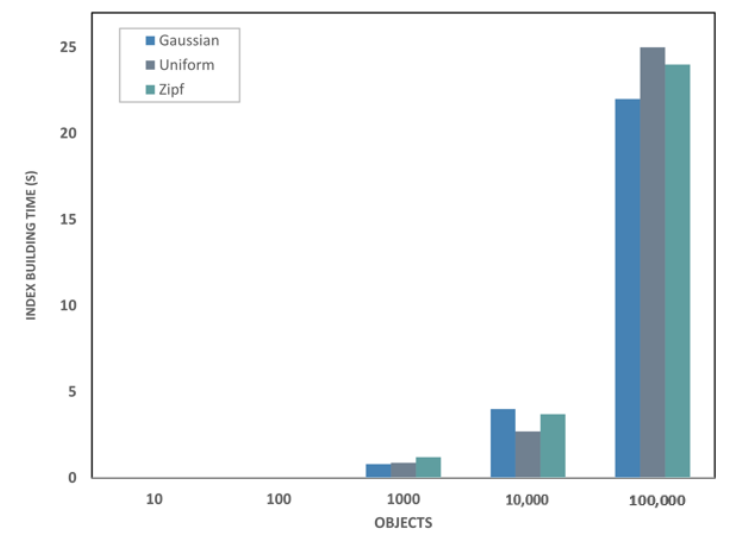
Figure 9. The construction time of VeST.